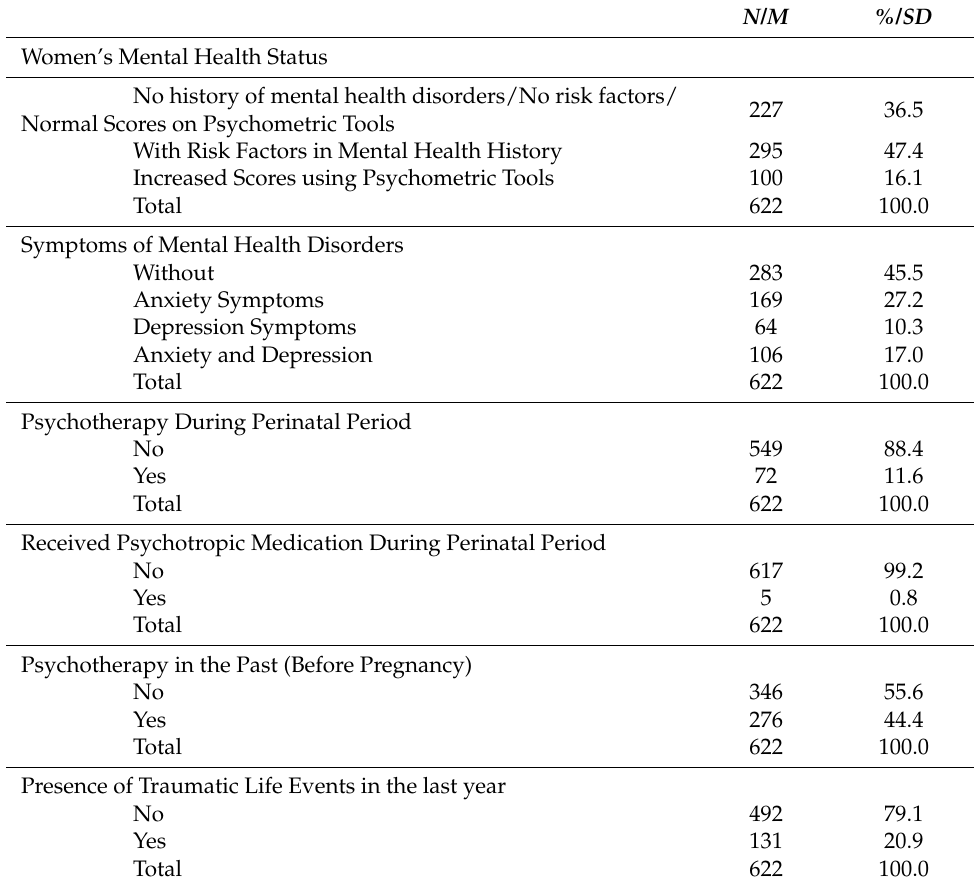
Table 2. Mental health characteristics.